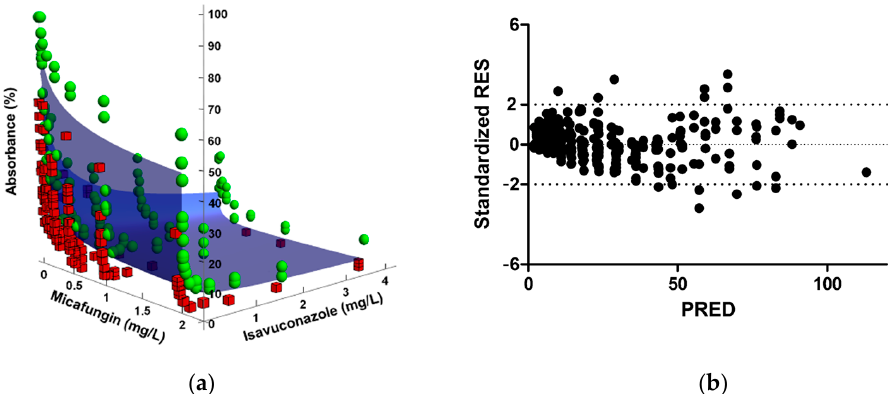
Figure 1. Goodness-of-fit plots of the Greco model for the combination of isavuconazole and micafungin against C. auris CJ100. ( a ) The blue surface represents model predictions, the green spheres represent observations above the fitted surface, and the red squares represent observations below the fitted surface. ( b ) Standardized residuals (Standardized RES) versus predictions (PRED).